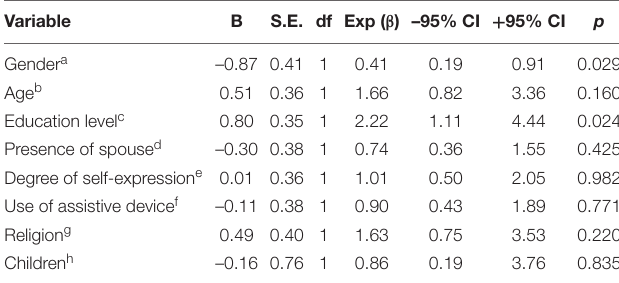
TABLE 5 | Summary of logistic regression analysis for preference of cognitive and affective activities.